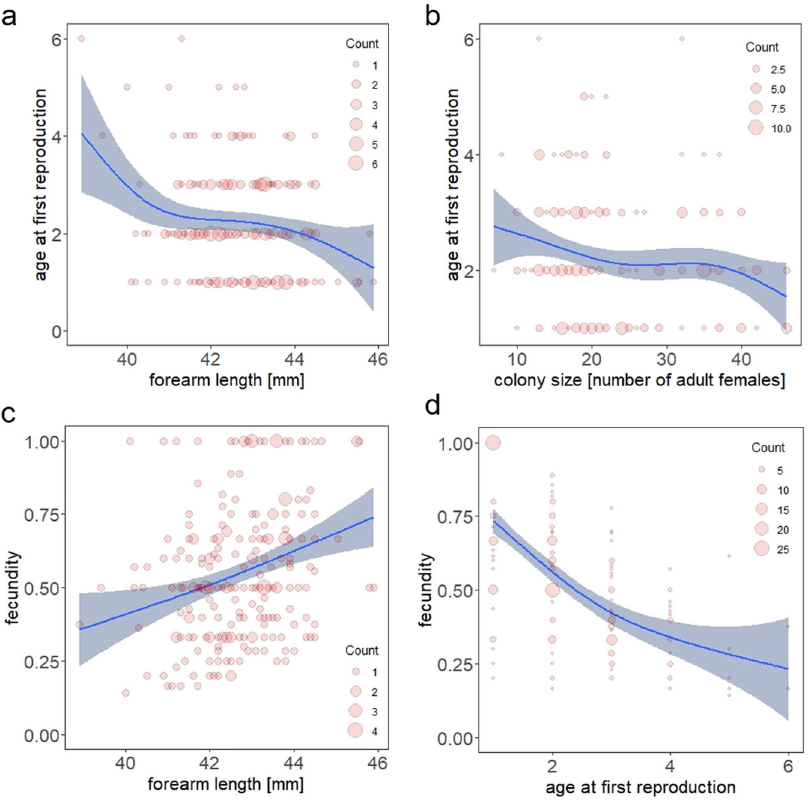
Fig. 2 Impact of body size and colony size on the life history traits of age at fi rst reproduction and fecundity. Impact of ( a ) body size and ( b ) colony size (as the number of adult females in a colony) on the age of fi rst reproduction (as age in years); and the impact of ( c ) body size and ( d ) age at fi rst reproduction on the fecundity (as the lifetime reproductive success divided by the number of breeding seasons) as smooth functions of a GAM ( k = 6, n = 225). Ninety- fi ve per cent con fi dence intervals are added. Count gives the number of overlapping data